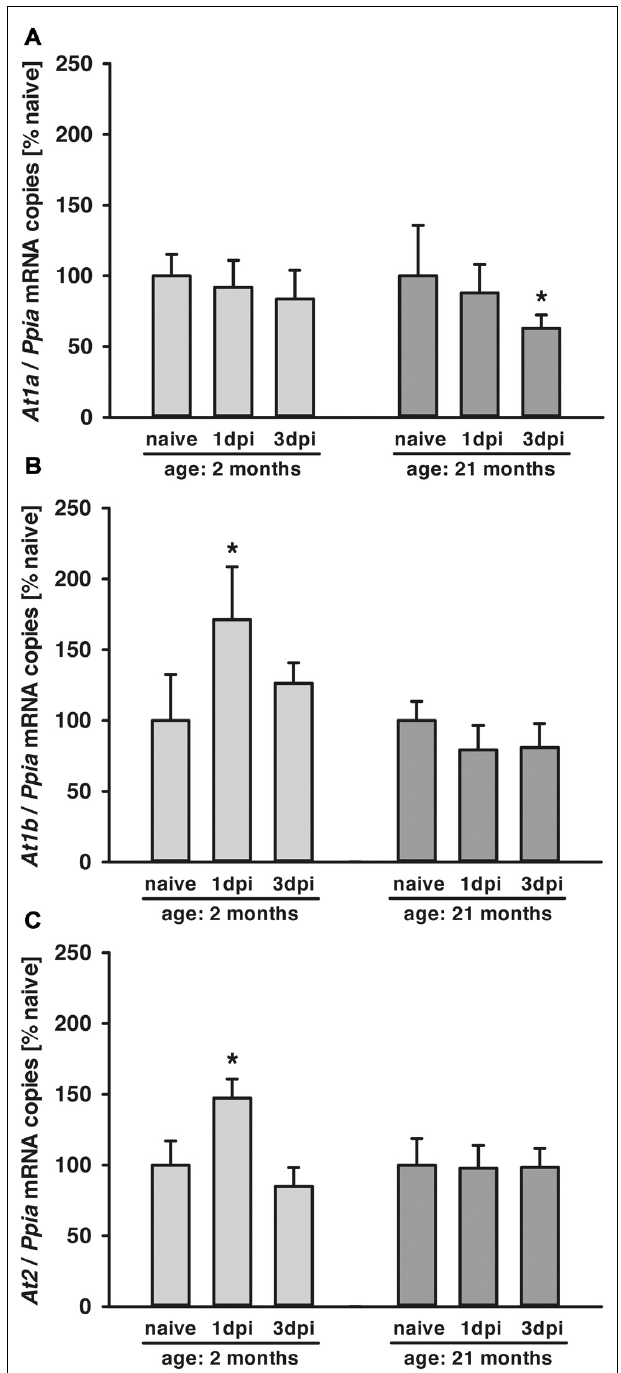
FIGURE 1 | Age-dependent posttraumatic At1a , At1b and At2 mRNA expression. (A–C) Angiotensin II receptor At1a , At1b and At2 mRNA expression was assessed by quantitative real-time PCR (qPCR) in 2 (light gray) and 21-months-old mice (dark gray) in naïve mice and at 1 dpi and 3 dpi (days post injury). Data were normalized with cyclophilin A ( Ppia ) and are presented as percentage of naïve expression levels [ ∗ p < 0.05 vs. naive; naïve animals (young and old: n = 6 each), 1dpi (young and old: n = 7 each) and 3 dpi (young: n = 7; old: n = 9; seven survived), Mann Whitney Rank Sum Test and Bonferroni-Holm correction; data is presented as mean ±